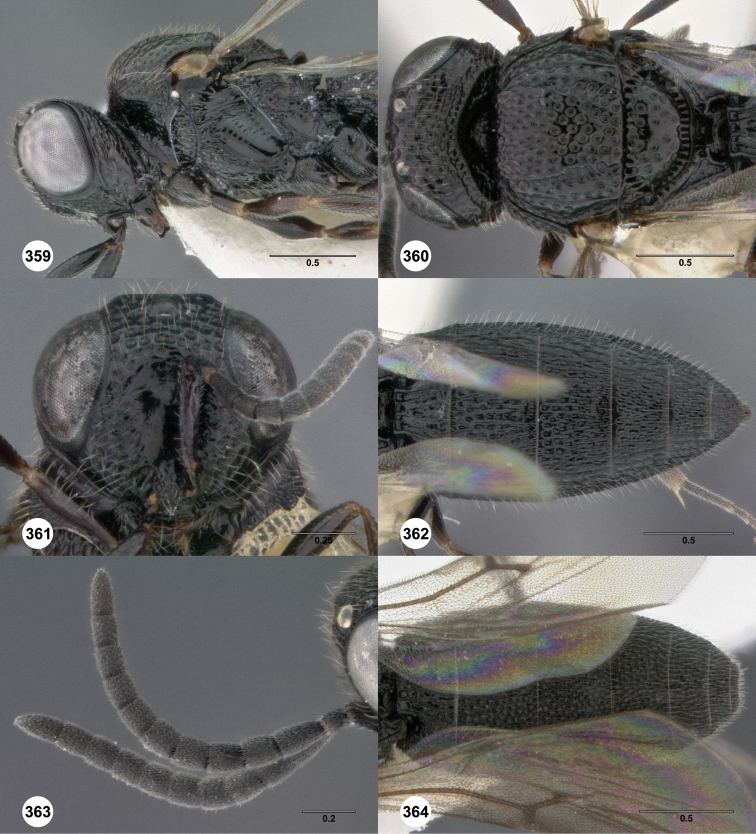
Oxyscelio tenuitatis sp. n., paratype female (OSUC 438285) 359 Head and mesosoma, lateral view. Holotype female (OSUC 438303) 360 Head and mesosoma, dorsal view 361 Head, anterior view 362 Metasoma, dorsal view. Paratype male (OSUC 438340) 363 Antenna 364 Metasoma, dorsal view. Morphbank96